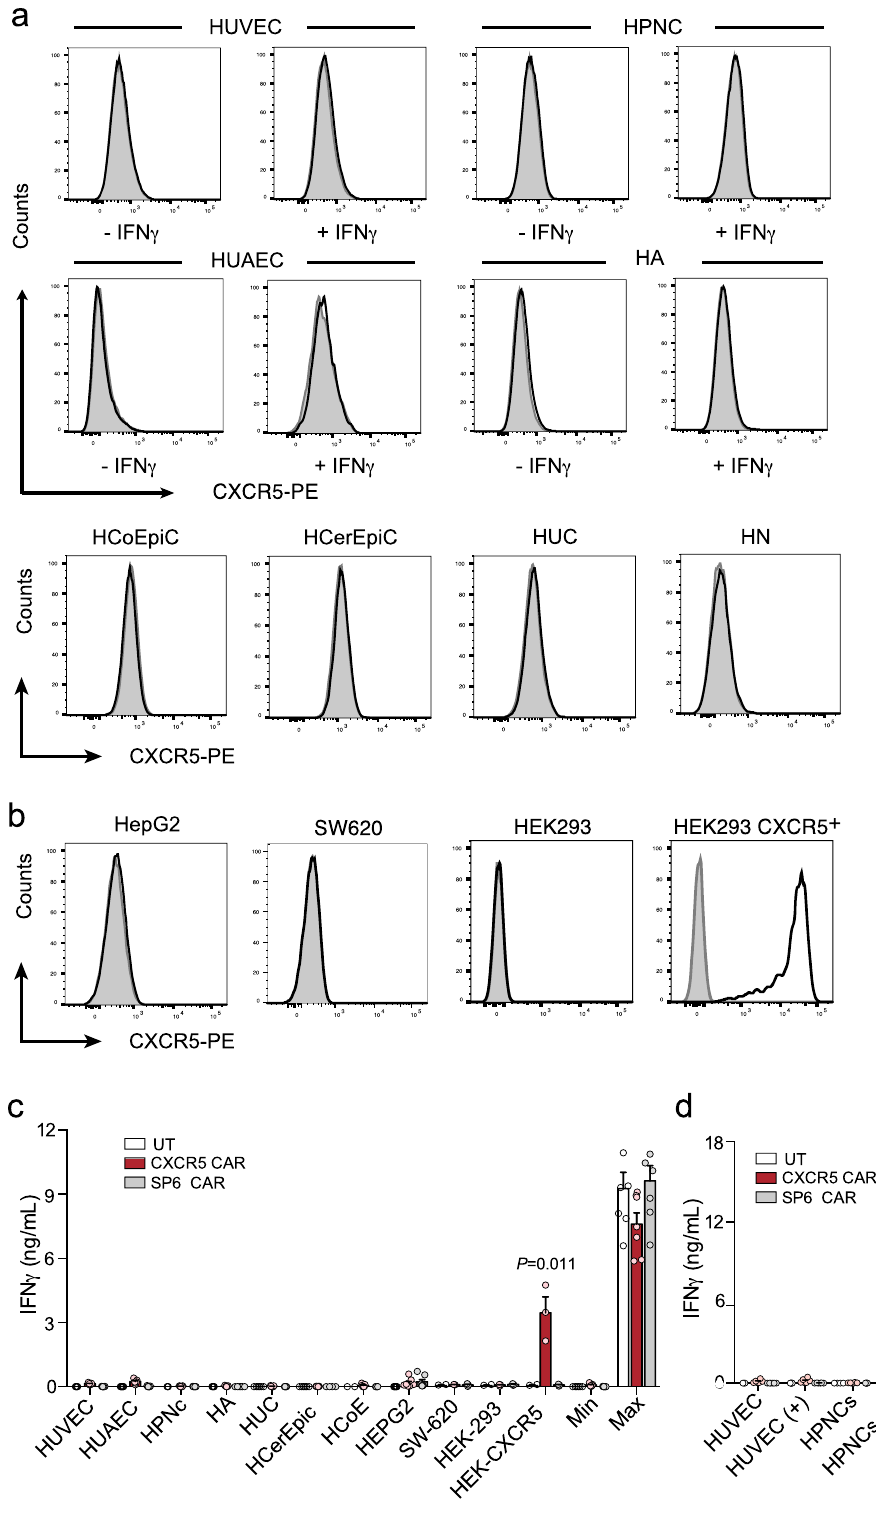
human CXCR5 CAR, however, all modules were of murine origin (Fig. 8a). Murine splenic T cells were transduced with the mCXCR5 CAR or GFP as negative control. CAR surface expression was in the range of >40% in murine T cells (Fig. 8b). The mCXCR5 CAR-T cells reacted speci fi cally against primary murine CXCR5 + / + E μ -Tcl1 leu- kemia cells, splenic B220 + B cells, and CXCR5-transduced BW5147 cells as indicated by a high release of mIFN γ and mIL2 (Fig.